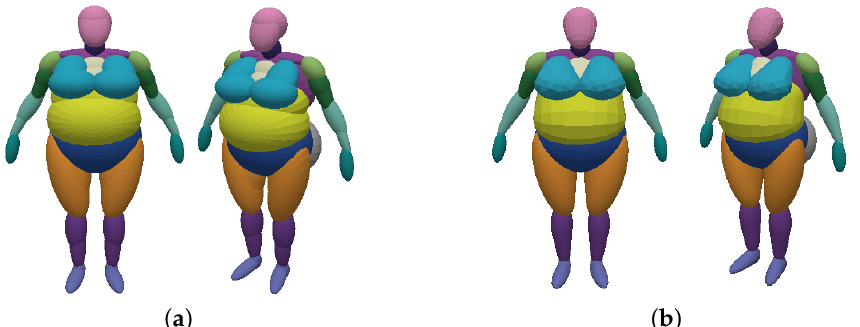
Figure 7. Mannequin approximated with cushions and ellipsoids. Ellipsoid mannequin ( a ) for comparison. Cushions computed according to Figure 5. Small chubby mannequin (see Section 3.3) as ( a ) Ellipsoid-based Mannequin and ( b ) Cushion-based